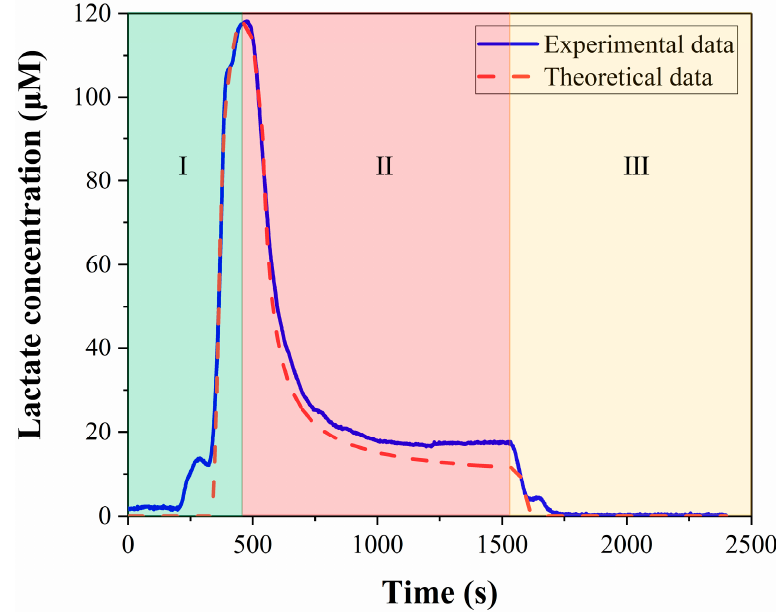
Figure 11. Comparison of theoretical analysis data with experimental data. Table 1. Summarized other methodologies for the lactate production